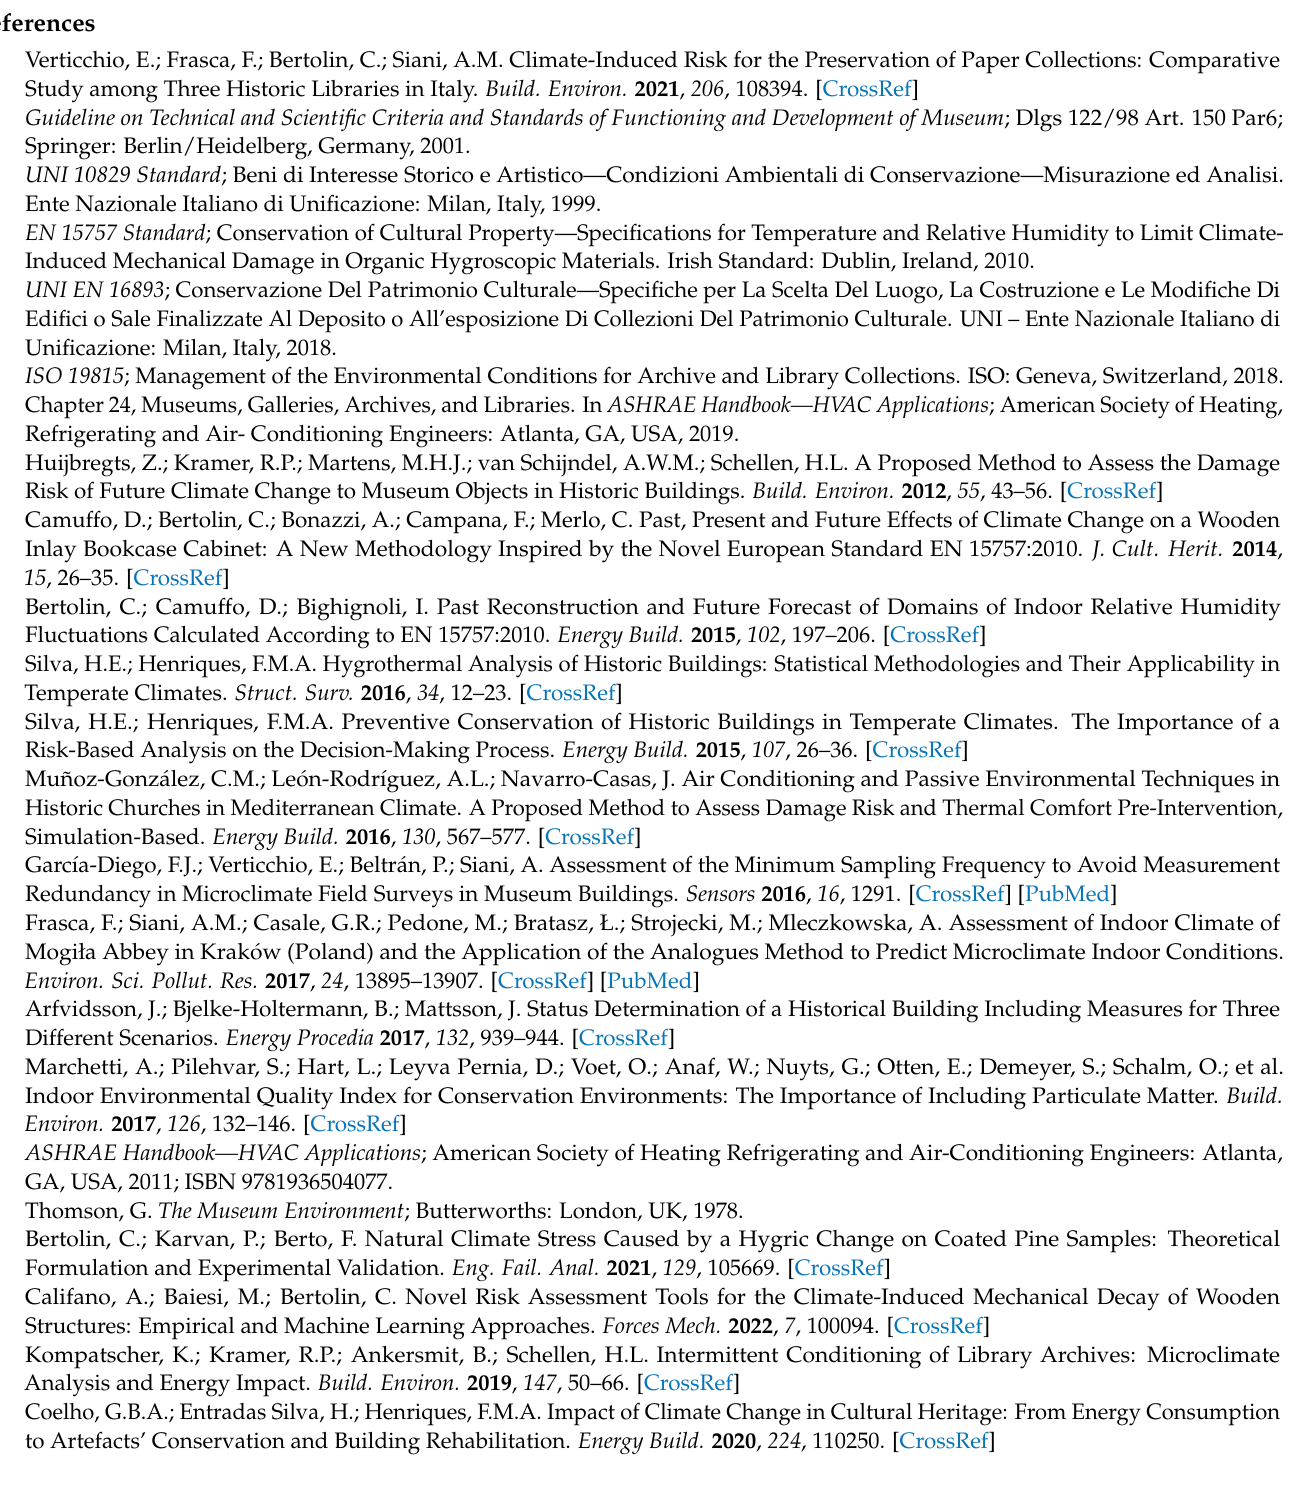
Figure A2a shows the measured indoor RH (blue curve), its moving average (MA) calculated over 30 days (black curve) and the 7th (bottom red curve) and 93rd (top red curve) percentiles of the RH fluctuations for Heddal church, calculated according to [3], over two years of observation (from 30 March 2019 to 30 April 2021). In addition, the outdoor RH is plotted with a light-grey curve. Figure A2b shows the indoor T (orange curve) and the outdoor T (green curve) in